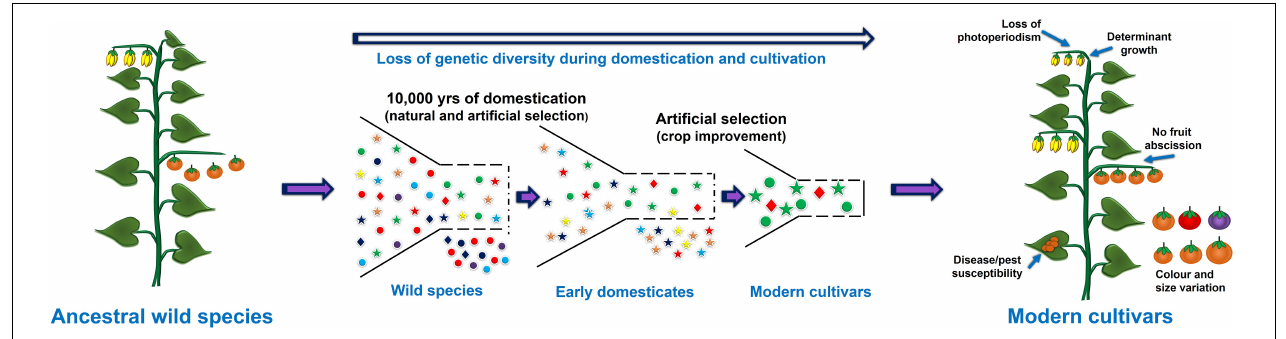
FIGURE 1 | Representation of domestication process and the loss of useful genetic variation due to selective breeding and selection of few alleles.